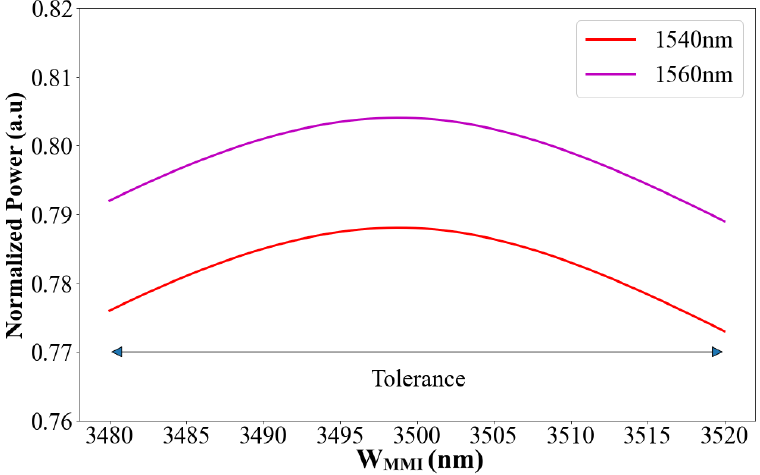
Figure 4. Normalized power as a function of MMI width for both wavelengths.